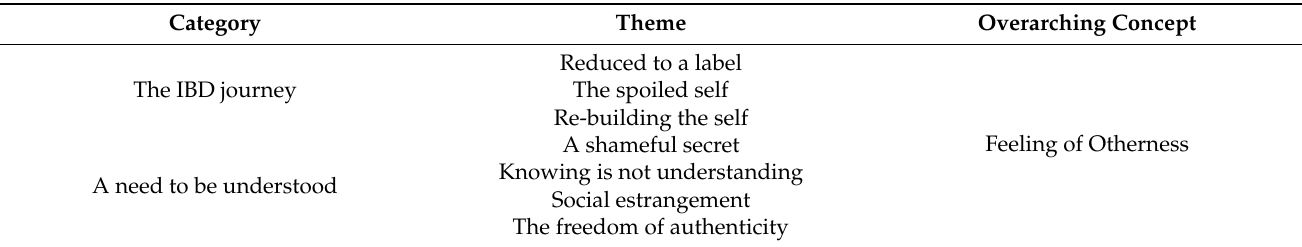
Table 3. Categories, themes, and overarching